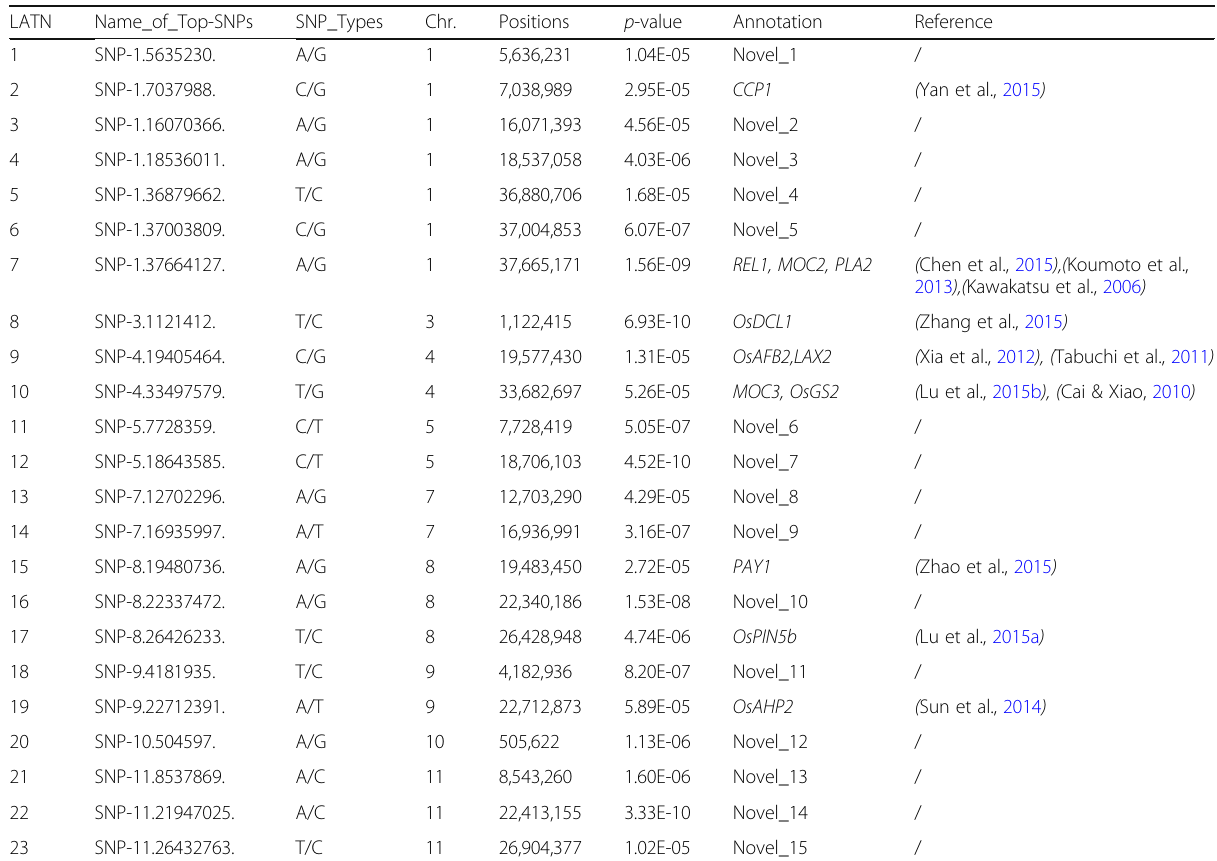
Table 1 The 23 LATNs and their rice genomic information